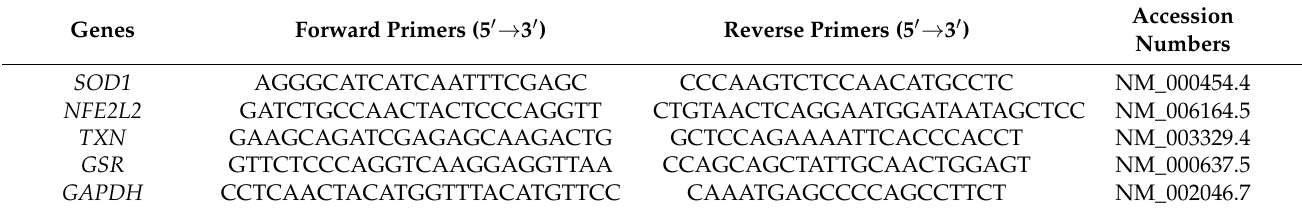
Table 1. Basic information for antioxidant-associated